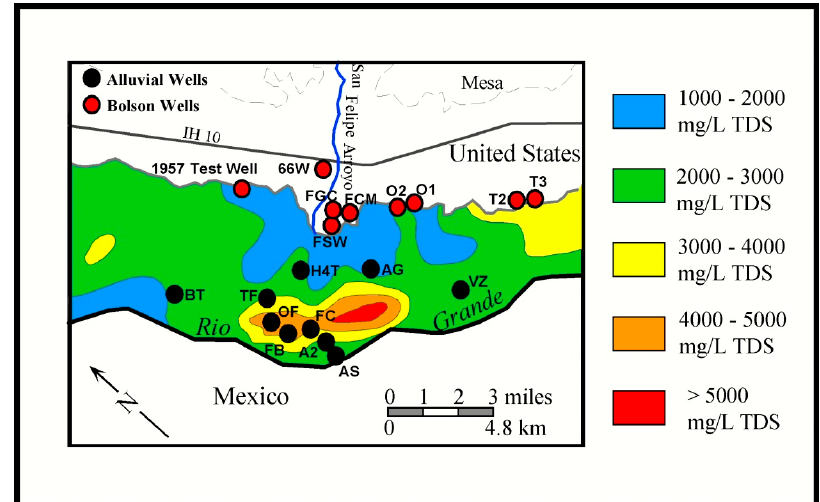
Figure 3. Study area map showing salinity of the Rio Grande Aquifer in the vicinity of Fabens, Texas showing that the most dilute water in the area is near San Felipe Arroyo. This figure also shows wells sampled in this study (alluvial aquifer salinities mapped by Alvarez and Buckner [12]; index map location shown in Figure